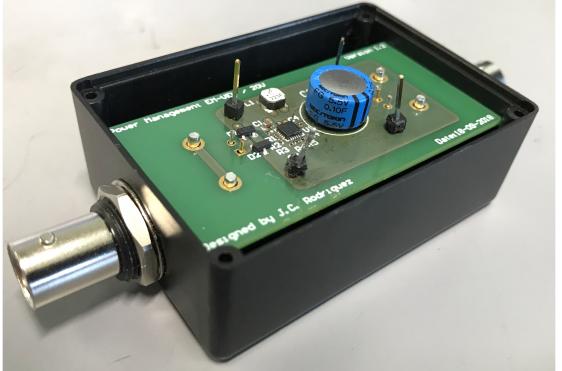
Figure 13. Power management